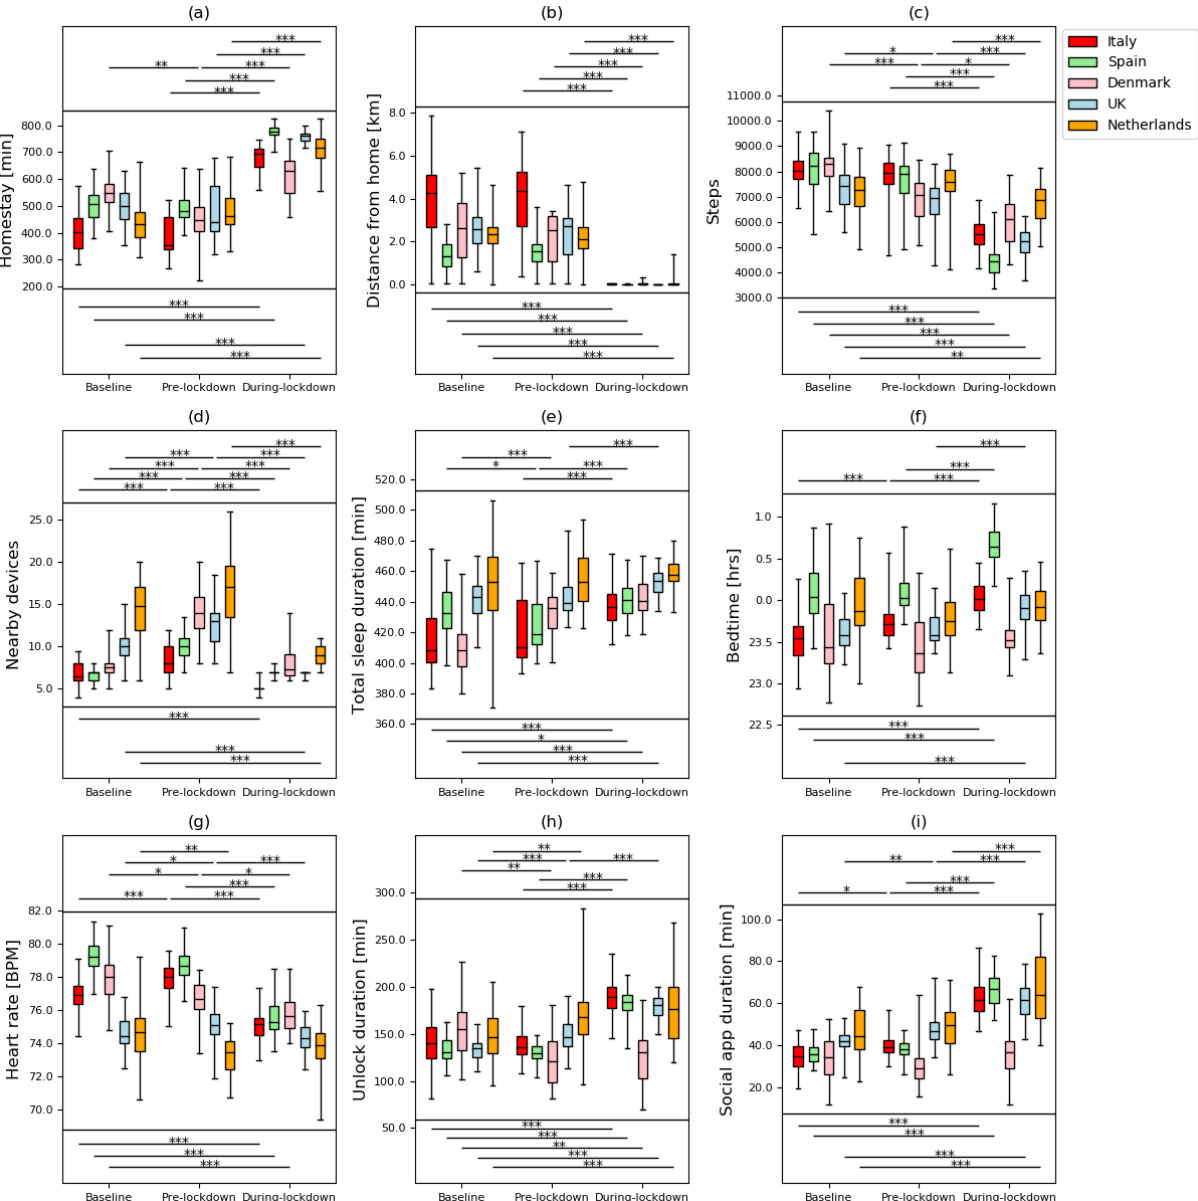
Figure 6. Box plots for comparisons among baseline, prelockdown, and during lockdown phases for different features. (a) homestay duration, (b) maximum distance from home, (c) Fitbit step count, (d) maximum number of nearby devices, (e) total sleep duration, (f) bedtime, (g) heart rate, (h) unlock duration, and (i) social app duration. *means P <.05, **means P <.01, ***means P